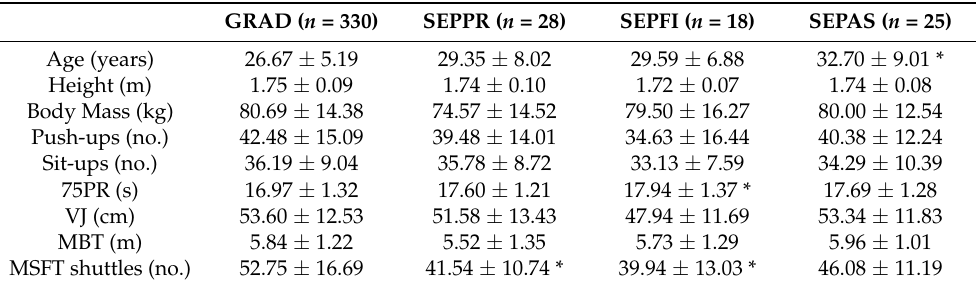
Table 2. Pairwise effect size data between LEA recruits who graduated (GRAD) or separated (SEPPR, SEPFI, and SEPAS) from academy training for age, height, body mass, number of push-ups and sit-ups completed in 60 s, time to complete the 75PR, VJ, MBT, and MSFT shuttles.